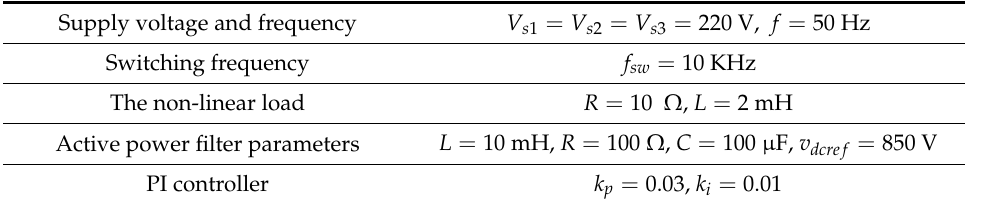
Table 1. Main Table 1. Main parameters.